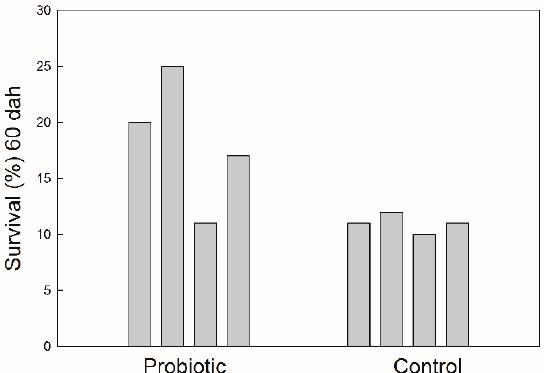
Figure 2. Survival of seabass juveniles expressed as a percentage of numbers of eggs stocked at the beginning of the trial.